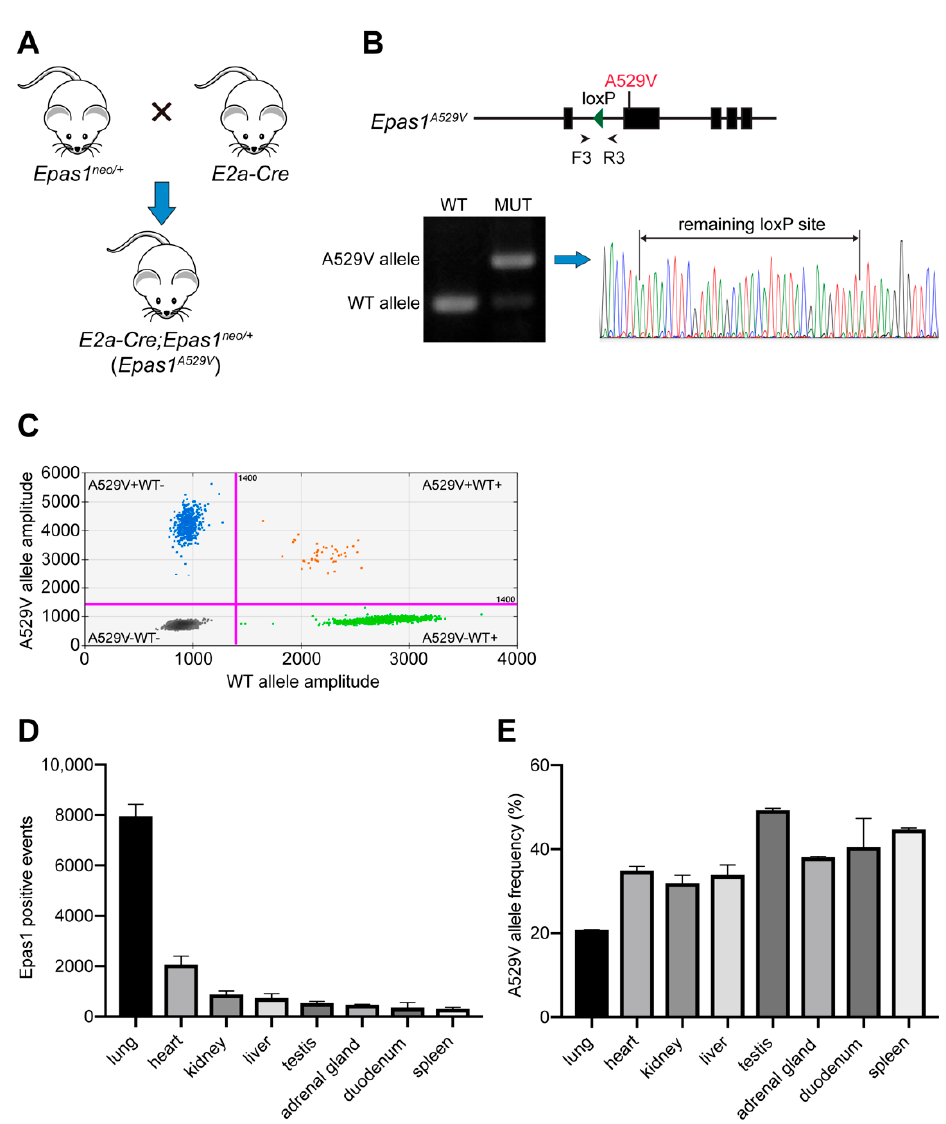
Figure 2. Successful expression of Epas1 A529V mutant allele in various tissues. ( A ) Mouse breeding strategy to generate the somatic mutant mice. ( B ) Genotyping PCR (F3/R3) and Sanger sequencing confirmed the successful deletion of the neomycin cassette by E2a-Cre in one-month-old Epas1 A529V mutant mice. ( C ) Representative image of Epas1 A529V droplet digital PCR (ddPCR). Green dots, droplets with PCR amplification of Epas1 wild-type (WT) allele. Blue dots, droplets with PCR amplification of Epas1 A529V mutant (MUT) allele. Orange dots, droplets with PCR amplification of both alleles. ( D ) Total Epas1 -positive events of Epas1 ddPCR from 100 ng cDNA of each tissue in two– three-month-old male mutant mice. n = 3. ( E ) Epas1 A529V allele frequency in the cDNA derived from each tissue.